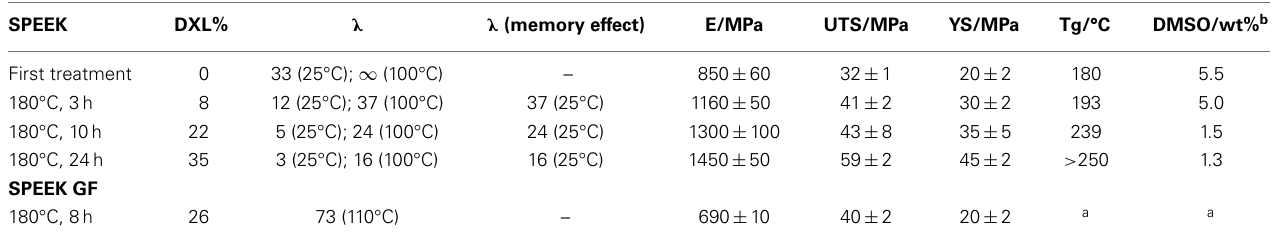
Table 1 | Memory effect and mechanical properties (E, elastic modulus, UTS, ultimate tensile strength,YS, yield stress) for various membranes in acid form .